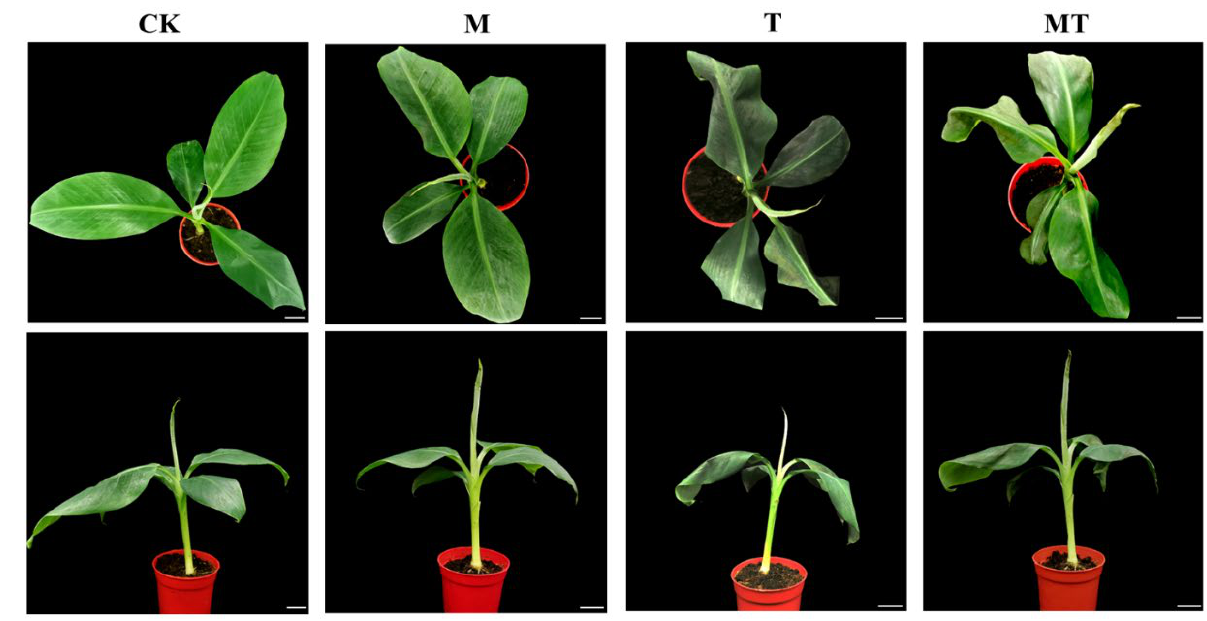
Figure 2. Typical phenotypes of 100 μM melatonin pre-treated and non-treated banana seedlings before and after 4 °C low-temperature treatment for 24 h. CK: control; M: melatonin treatment; T: low-temperature treatment; MT: combined melatonin and low-temperature treatment (bar = 4 cm).